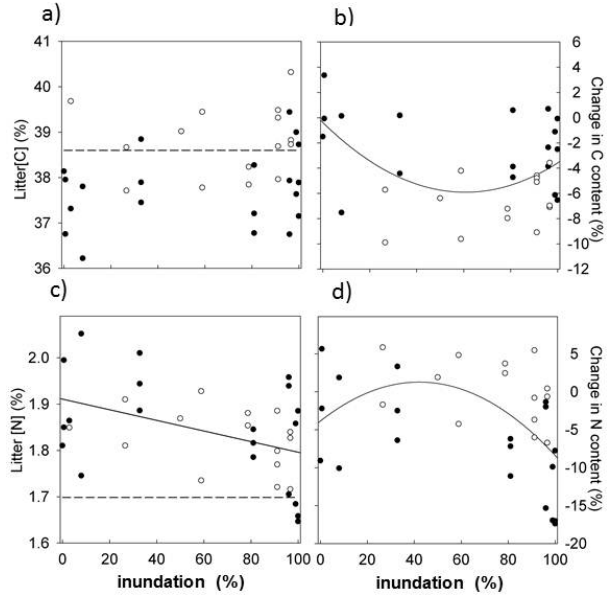
Fig. 4. C and N concentrations of decomposing litter (left) and change in C and N mass during decomposition (right). Filled circles represent results from the Blackwater River site, and open circles represent results from the Rhode River site. Dashed lines in left panels indicate initial concentration of C and N. Solid lines denote trends between flooding duration and element concentration or mass loss. Regressions correspond to data from both sites, although the relationship between N loss and inunda- tion is also signficant at the Blackwater site alone (not